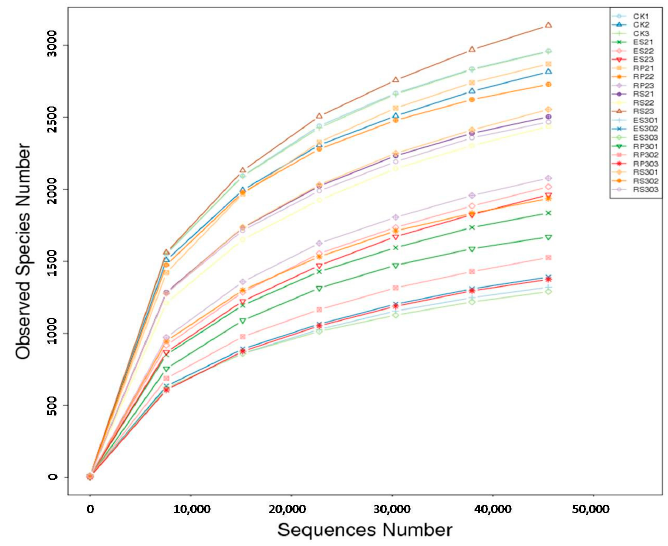
Figure 2. The rarefaction curve based on 97% similarity. CK1, CK2, CK3 refer to the bulk soil, RS21, RS22, RS23 represent rhizosphere of the two-year-old tea plantation, RP21, RP22, RP23 represent rhizoplane of the two-year-old tea plantation, and ES21, ES22, ES23 represent endosphere of the two-year-old tea plantation respectively. While RS301, RS302, RS303 represent rhizosphere of the thirty-year-old tea plantation, RP301, RP302, RP303 represent rhizoplane of the thirty-year-old tea plantation, and ES301, ES302, ES303 represent endosphere of the thirty-year-old tea plantation respectively.